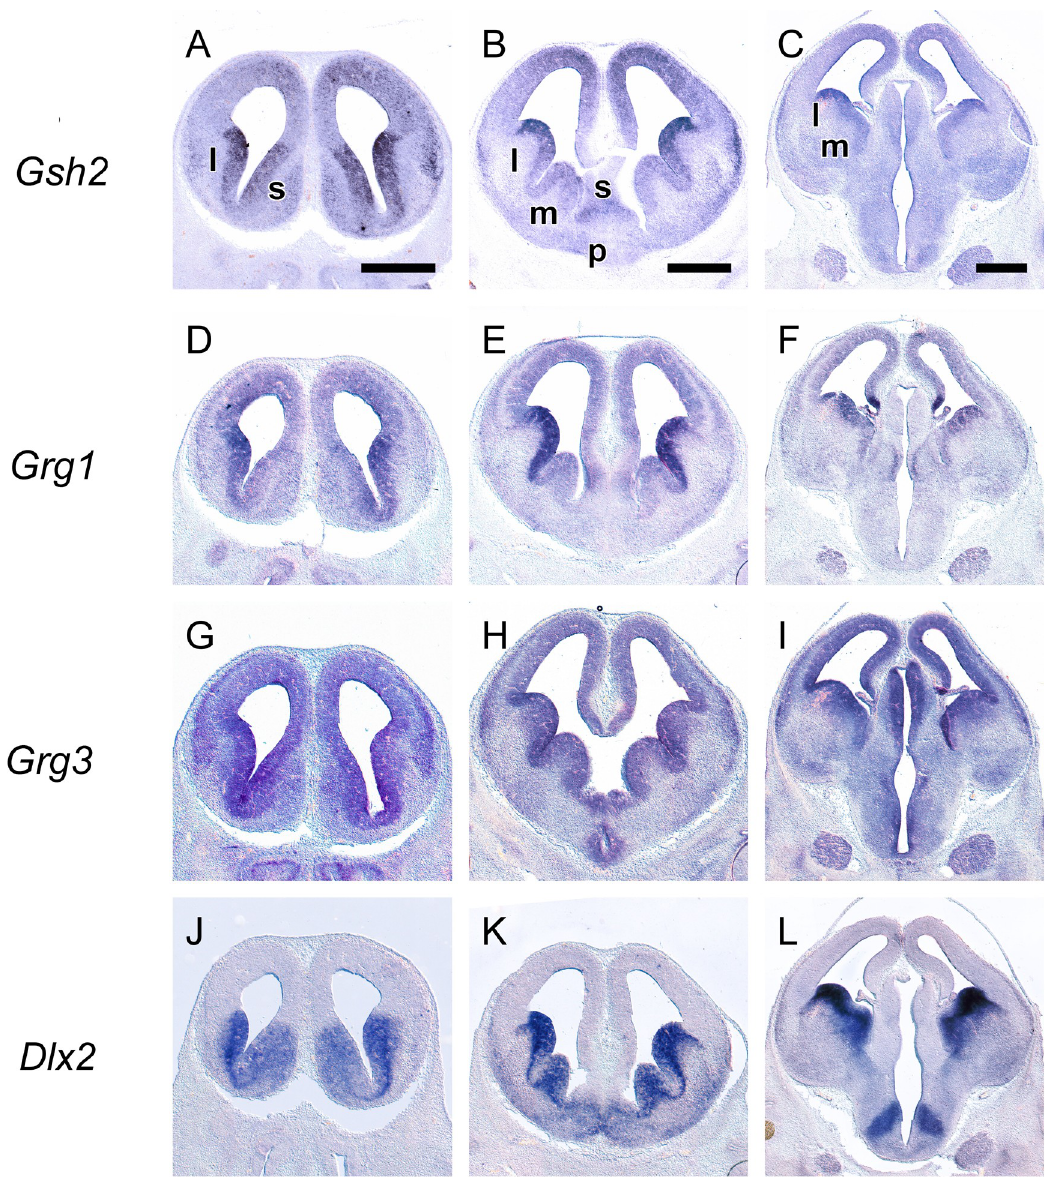
Fig 7. In situ hybridization on adjacent coronal sections through the embryonic telencephalon from rostral (left) to caudal (right) levels hybridized with an antisense RNA probe of Gsh2 (A—C), Grg1 (D—F), Grg3 (G-I) and Dlx2 (J—L) m: MGE, l: LGE, l: LGE, s: septum, p: preoptic area. Scale: 500 μ